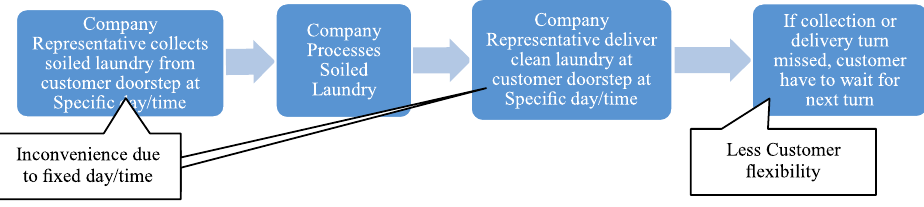
FIG. 1. COLLECTION / DELIVERY OF LAUNDRY FROM CUSTOMER DOORSTEP BY DHOBI